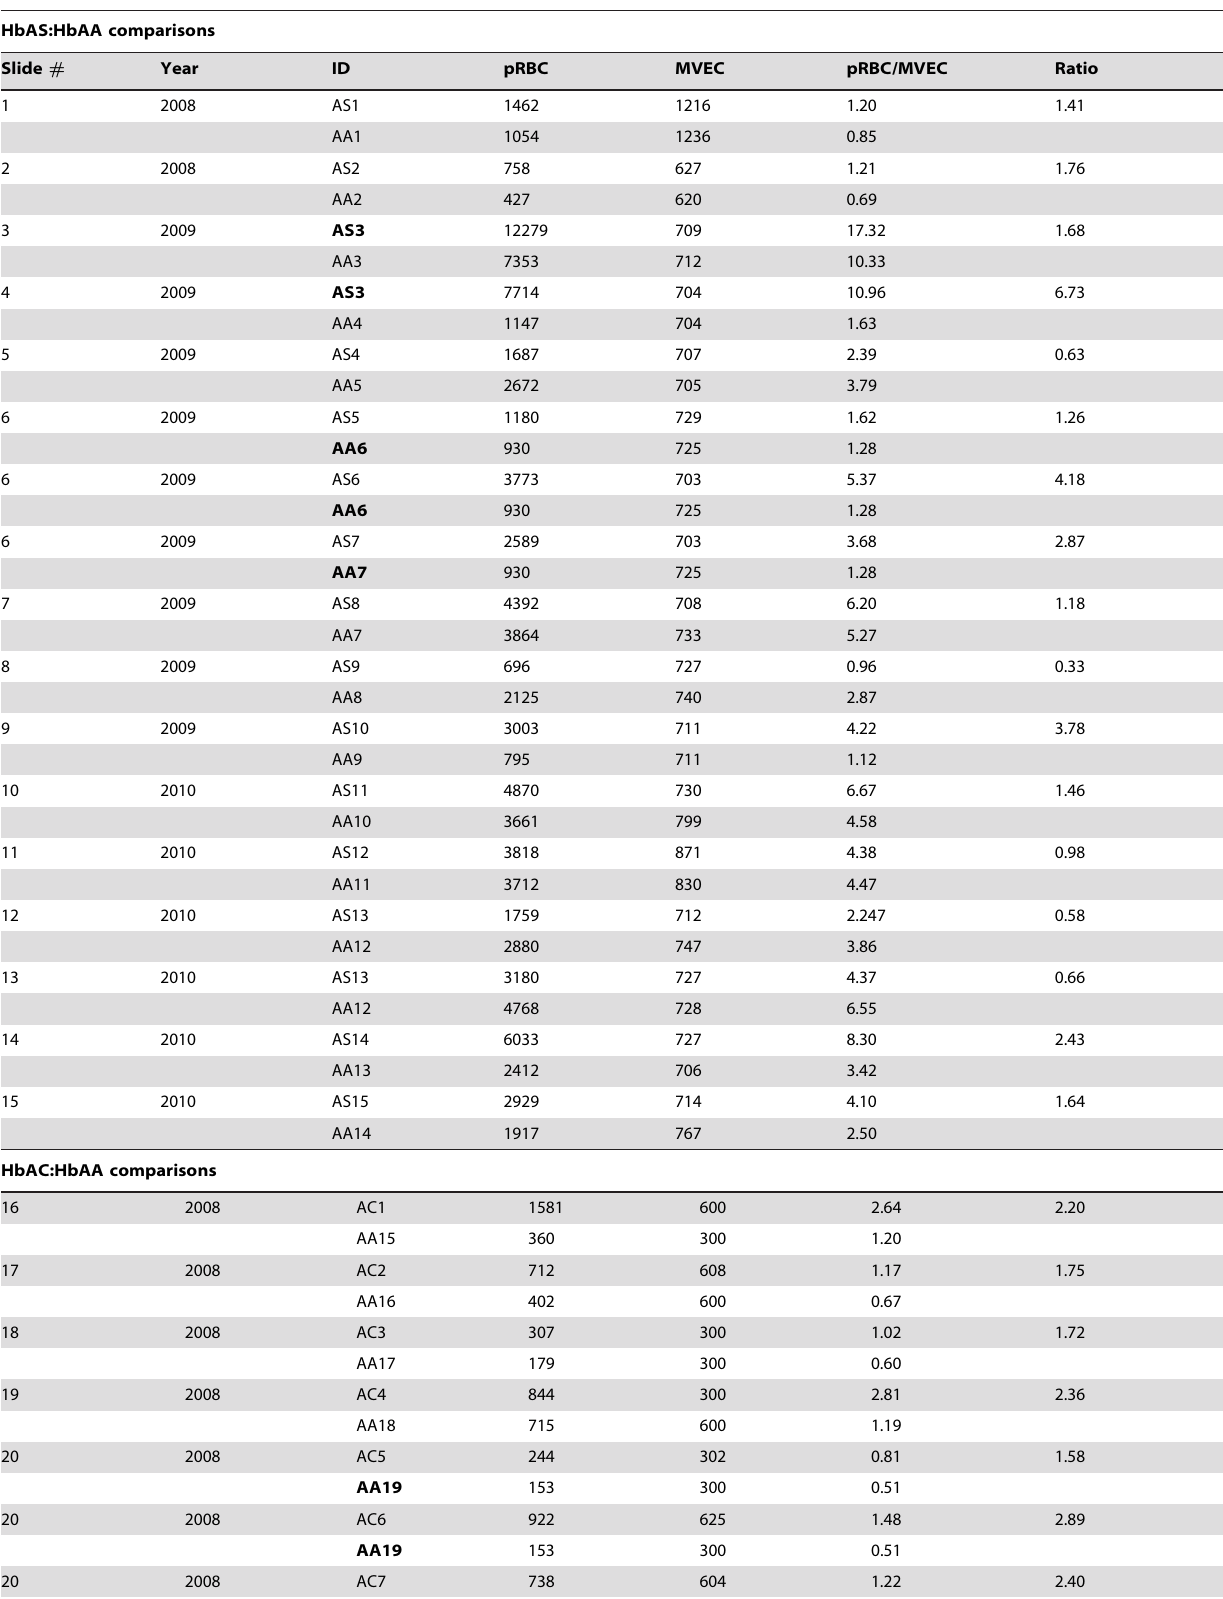
Table 2. Relative cytoadherence of parasitized HbAA, HbAS, and HbAC RBCs to MVECs.